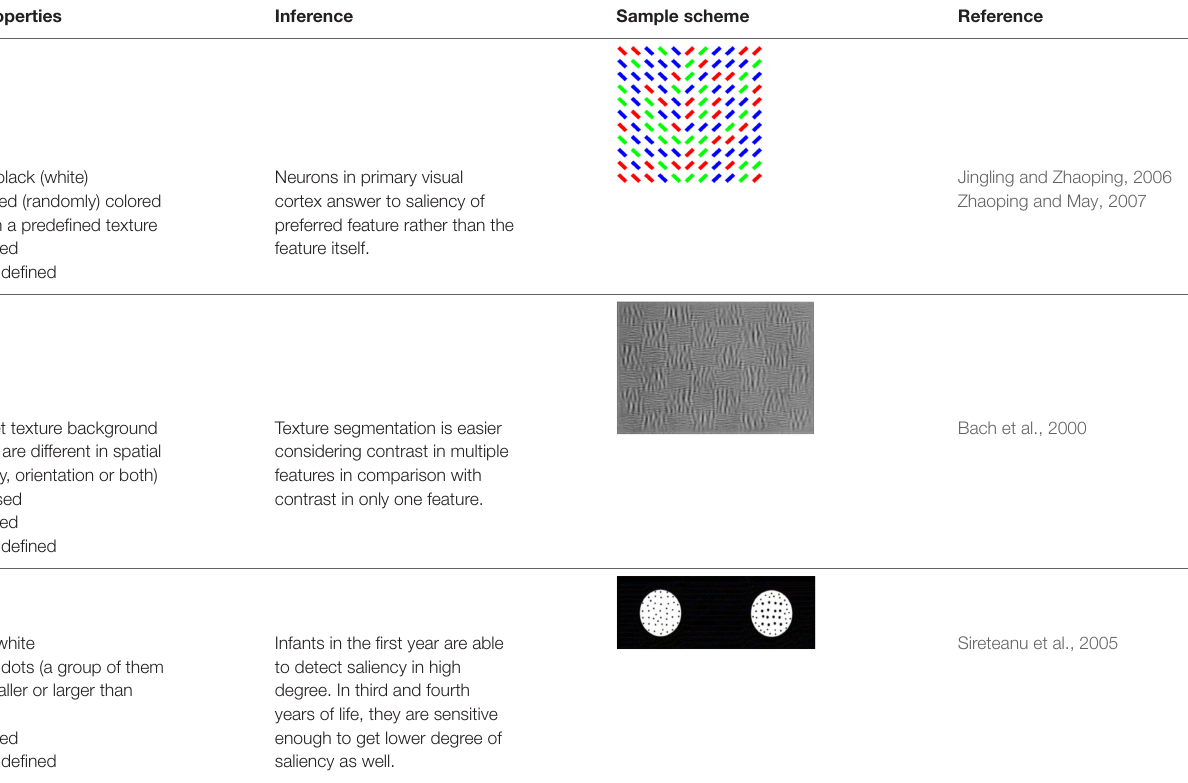
TABLE 3 | An overview of common texture segmentation